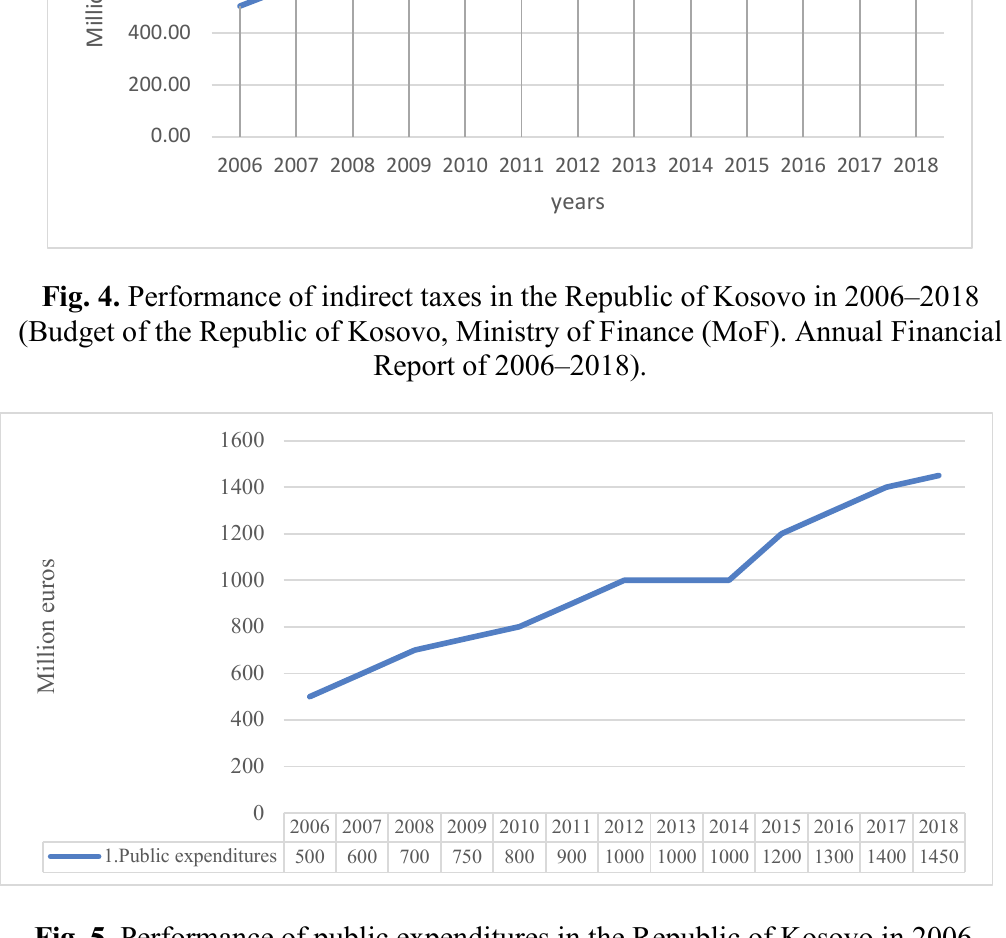
Fig. 5. Performance of public expenditures in the Republic of Kosovo in 2006– 2018, million euros (Budget of the Republic of Kosovo, Ministry of Finance (MoF). Annual Financial Report of